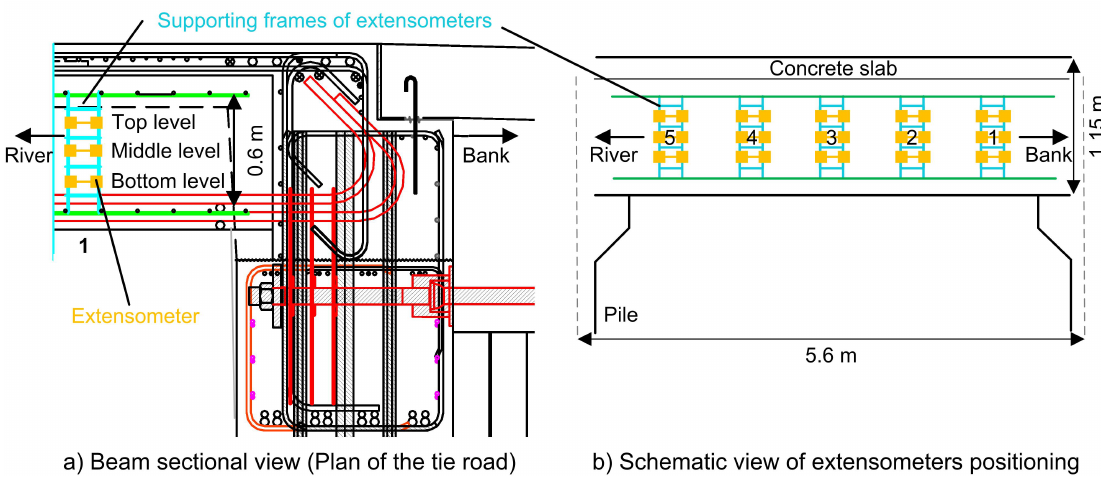
Figure 6. Instrumentation for strain measurement (beam